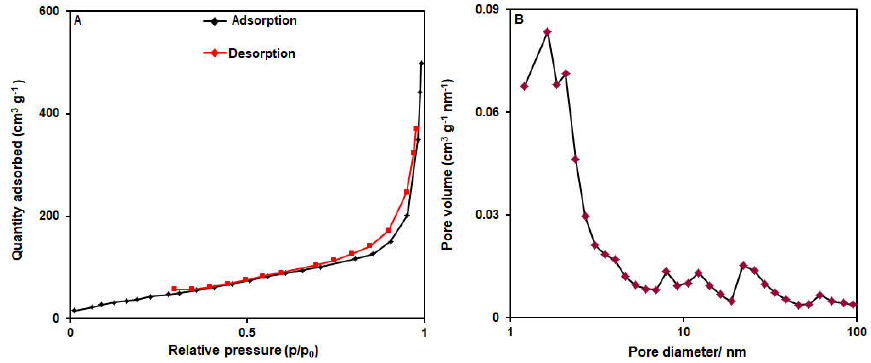
Figure 4. ( A ) N 2 adsorption/desorption isotherms and ( B ) pore size distribution curves of bimetal- lic NiCo-MOF nanosheets.